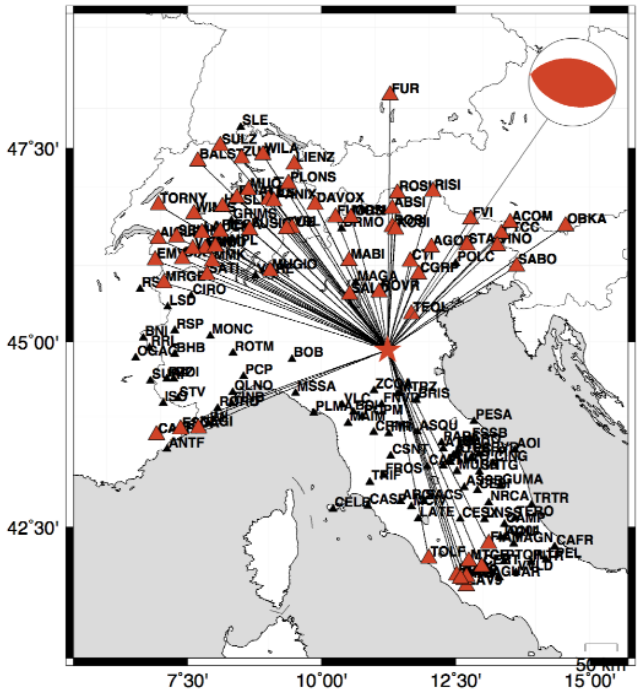
Figure 3. Above: (a) Comparison between synthetic and recorded traces (six stations of 64 used) for the moment tensor automatic solution of the Emilia May 20, 2012, M 5.9 earthquake. Below: (b) Map of the stations that contributed to the moment tensor automatic solution for the Emilia May 20, W 2012,